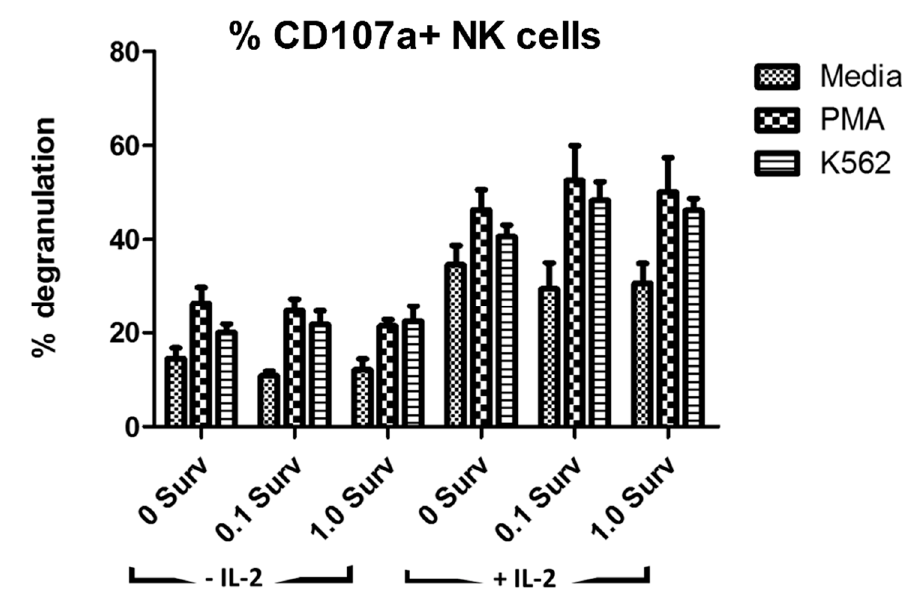
Figure 4. Degranulation of NK cells affected by IL-2 and activation by PMA and K562, but not by survivin. Peripheral blood mononuclear cells (PBMCs) from healthy donors ( n = 7) were treated with recombinant survivin protein (0–1.0 µg/mL) with or without IL-2 (100 U/mL) for 36 h. Degranulation activity of the gated CD56+ NK cell population was measured after 6 h of stimulation by PMA (10 ng/well) and ionomycin (50 ng/well) as positive control, K562 target cells (5 × 10 5 /well), or media control using flow cytometry. Data presented as % of total gated NK cells that were CD107a-FITC +. For flow cytometry, data were collected on a Miltenyi MACSQuant Analyzer flow cytometer and analyzed using FlowJo v10.0.8p software.